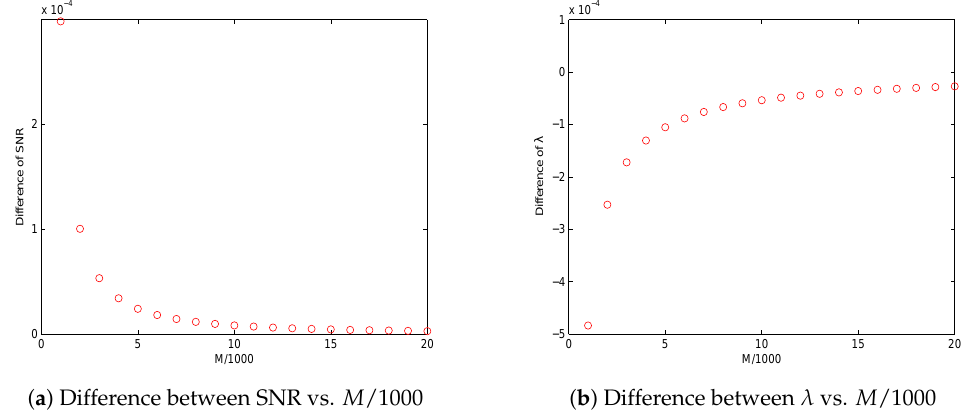
( a ) Difference between M vs. 1/SNR ( b ) Difference between λ vs. 1/SNR Figure 4. The plot of differences between the solutions ( M , λ ) for ( k = 1,2, . . . ,20, under setting α = 0.05 and σ n = 1. ( a ) The plot of the differences between solutions M of ( NP 1 ) and (NP 1 ) vs. 1/SNR. ( b ) The plot of differences for the corresponding λ vs. 1/SNR. (cid:102)